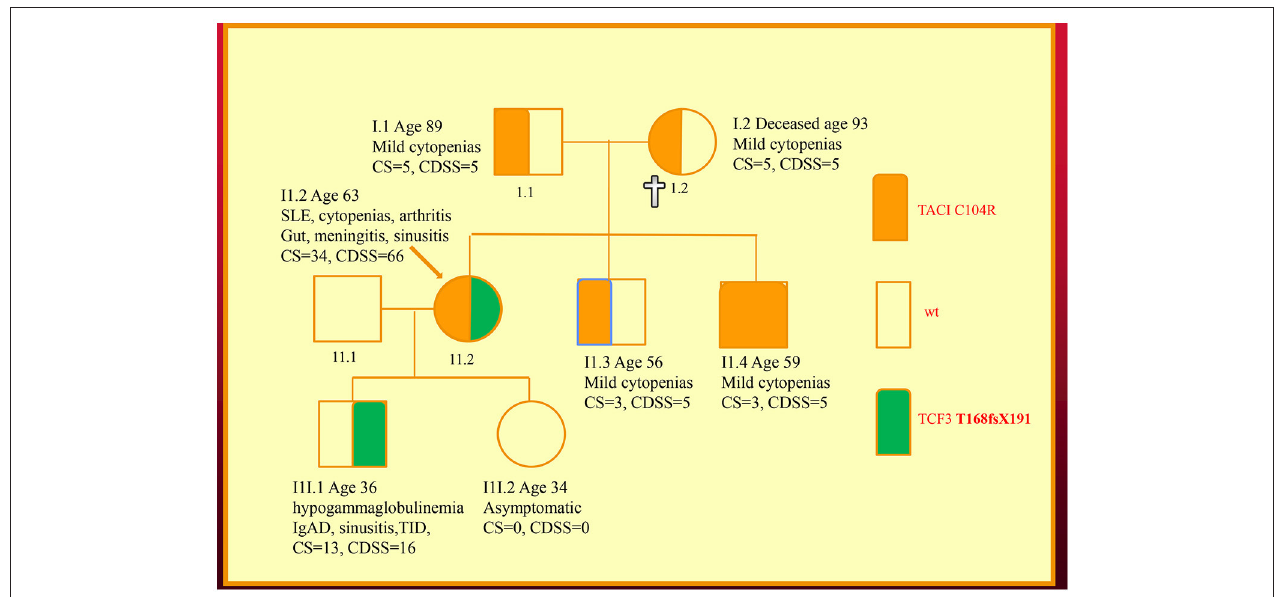
FIGURE 1 | Family with a digenic CVID-like disorder caused by epistatic interactions of TNFRSF13B /TACI and TCF3 genes. The proband (arrow) suffers from both a severe immunodeficiency as well as SLE. Other members are as described in our previous publications including a mild symptomatic brother (II.3) with severe